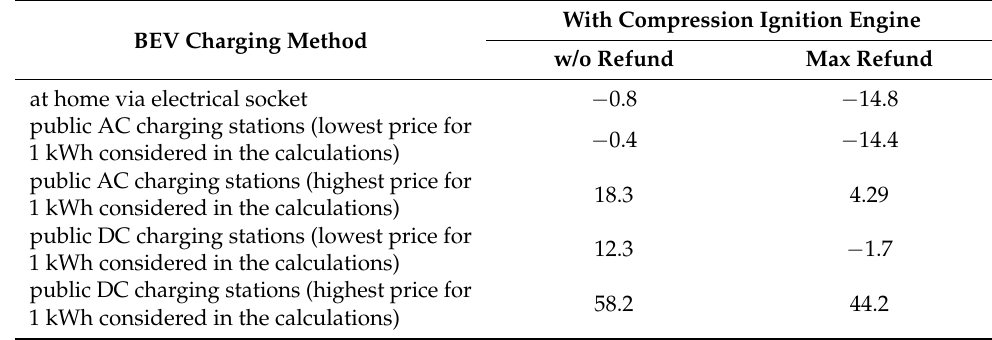
Table 4. Difference between the total cost of ownership (TCO) for an electric vehicle and for a combustion engine vehicle